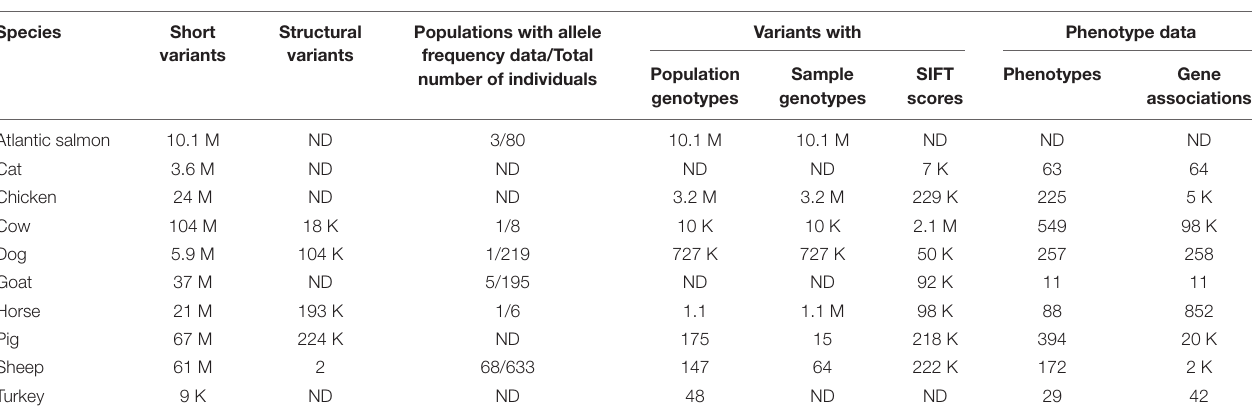
TABLE 4 | Variation data counts for livestock and companion animal